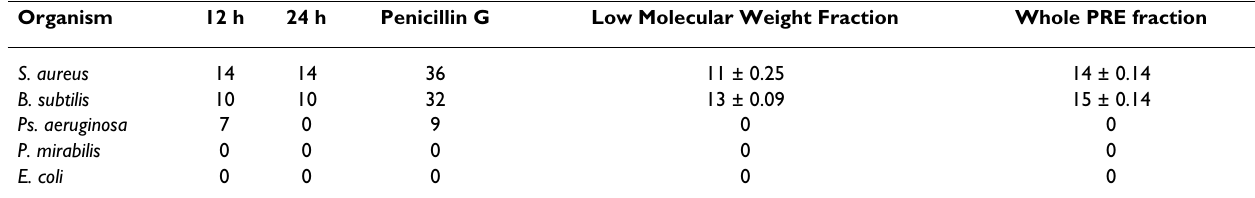
Table 1: Diameter of the zones of inhibition (mm) of the autoclaved pomegranate rind extract compared to penicillin and the results of the fractionation PRE against a panel of five bacteria. Organism 12 h 24 h Penicillin G Low Molecular Weight